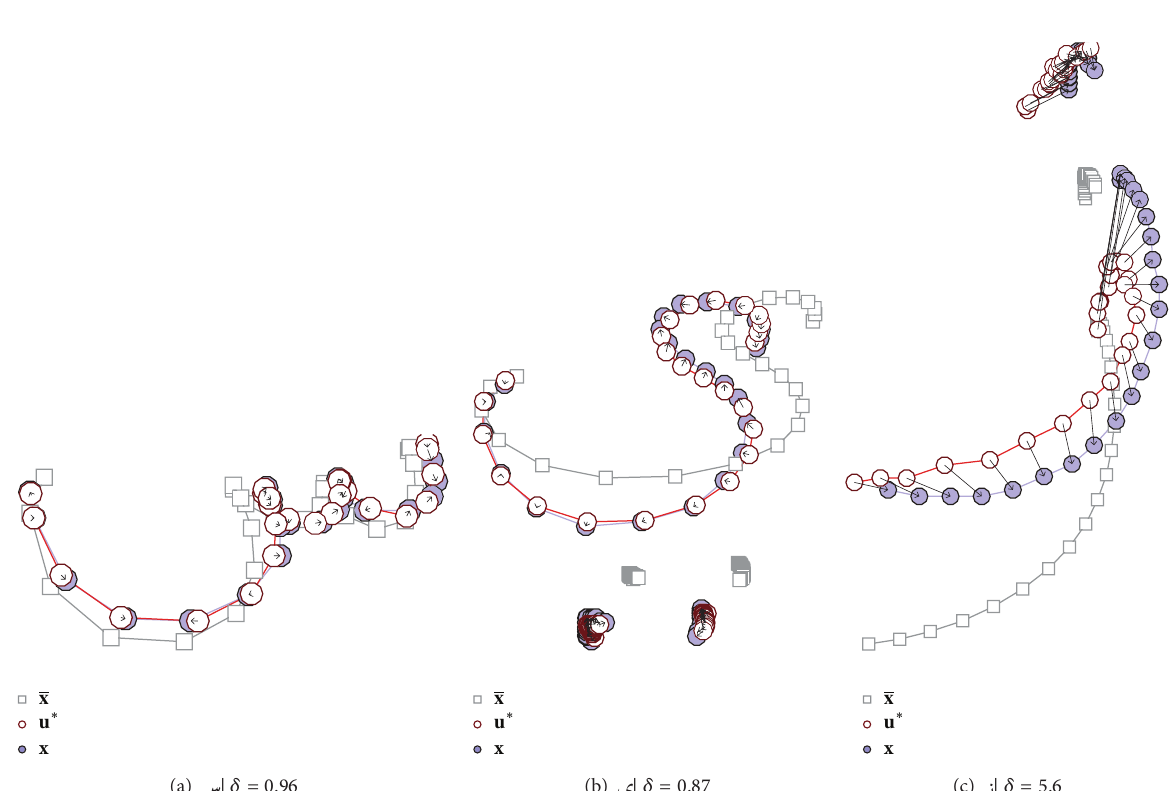
Figure 4: Examples of ASM based glyph u ∗ that has the highest correlation (deviation 𝛿 ) with a randomly chosen samples x . The average sample polygon x is displayed to show how strong x differs from the expected shape. Some of the ASM for characters with diacritics are problematic, as shown in (c).